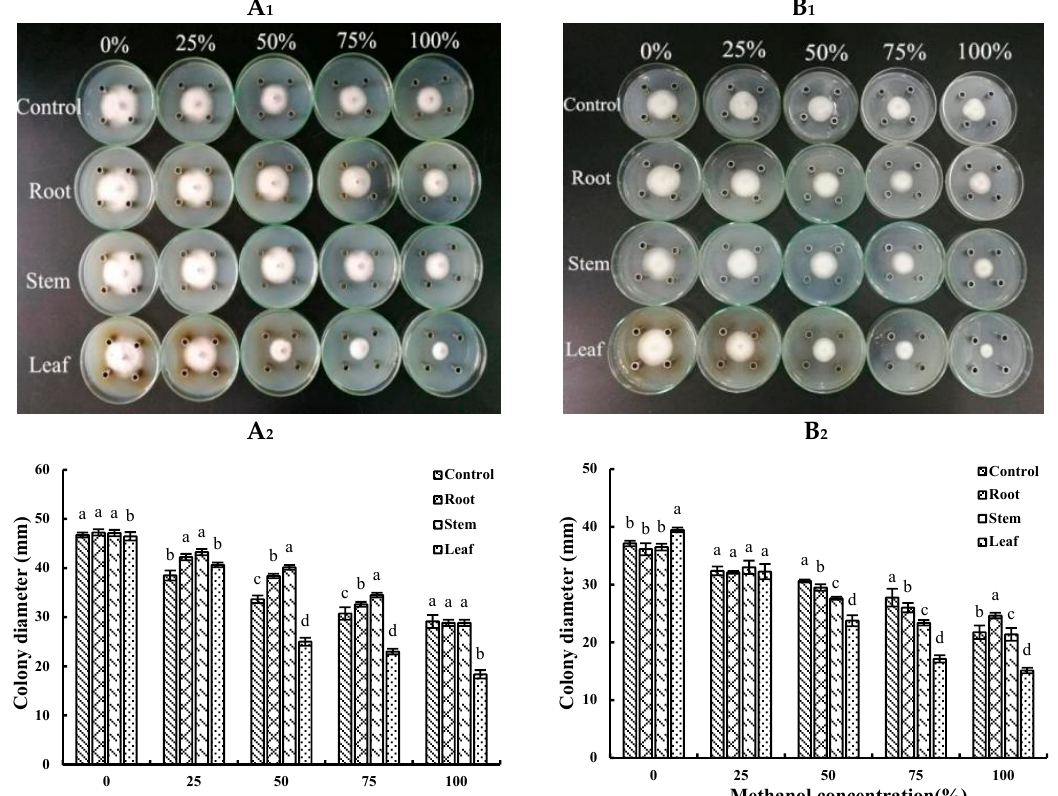
Figure 2. ( A 1 ): Effects of different concentrations of methanol crude extracts from A . annua against F . oxysporum , and the mycelium growth for 5 days. ( B 1 ): Effects of different concentrations of methanol extracts from A . annua on F . solani . ( A 2 ): The colony diameter (mm) of F . oxysporum by treated with different crude extracts. ( B 2 ): The colony diameter (mm) of F . solani by treated with different crude extracts. Note: Different letters represent significant differences ( p < 0.05) among different plant parts at the same methanol concentration, while with the same letters mean no significant difference ( p > 0.05).